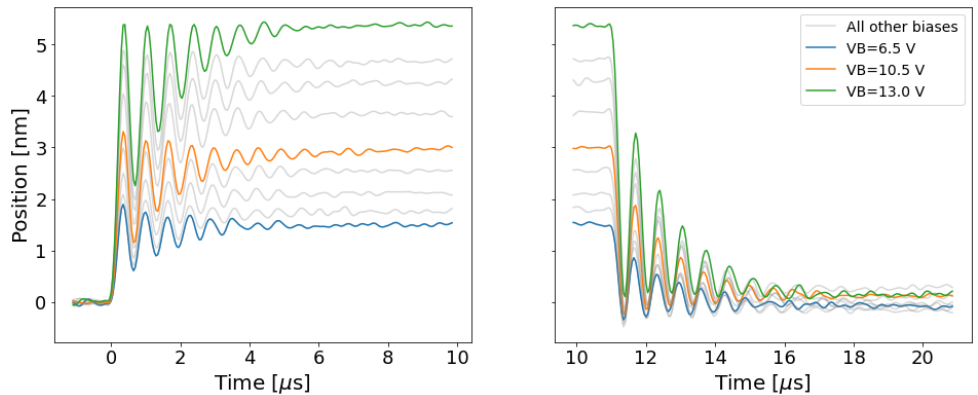
Figure 4. Plots of the displacement of a relay during the transient at each value of V b . Positive displacement is measured towards the LDV laser source, so more positive values of displacement are farther from the substrate. ( left ) A plot of the displacement transient when the relay is opening. ( right ) A plot of the displacement transient when the relay is